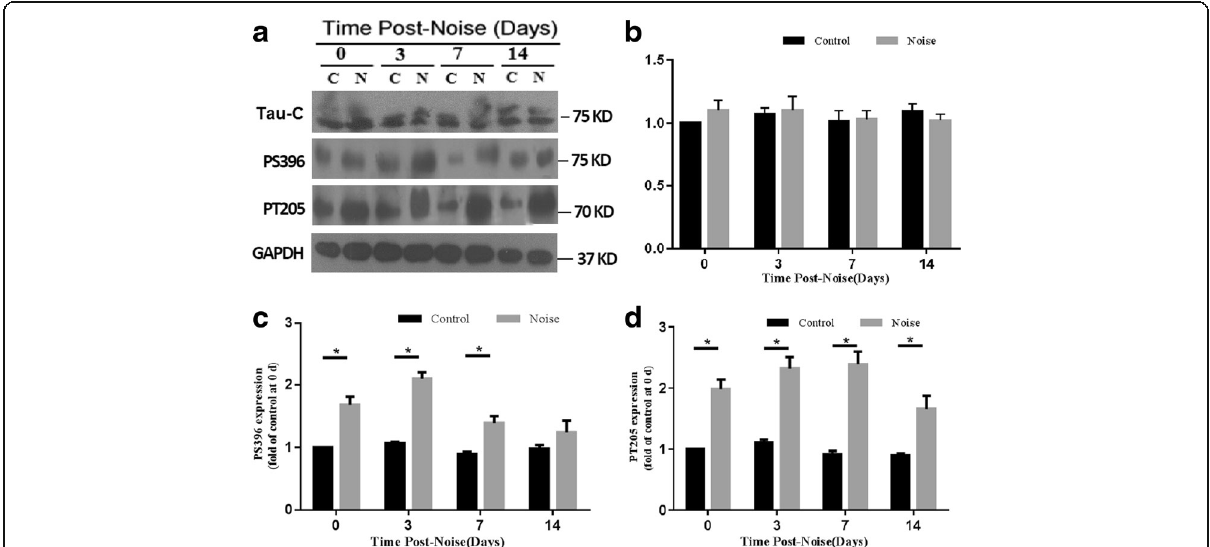
Fig. 3 Chronic noise exposure increases hyperphosphorylated tau in the hippocampus. Western blot analysis of hippocampal phosphorylated tau under control (C) and chronic noise exposure (N) conditions. Immunoblot panels were probed with anti-tau or phosphorylation-dependent anti-tau antibodies as indicated ( a ). The density of the immunoreactive bands was quantified and is presented as the percentage change relative to the control samples ( b , c , and d ). GAPDH was used as the loading control. Bars represent mean ± SD ( n = 6 for each condition). * p < 0.05, compared with respective controls ( n = 6 per group)